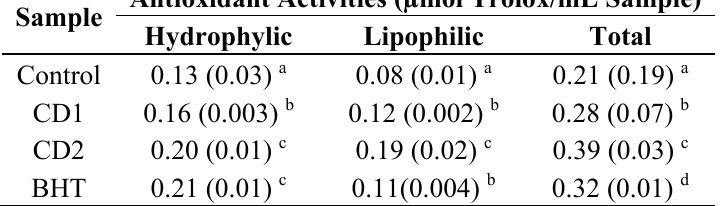
Figure 1. ( a ) AOC measured by FRAP water; ( b ) and FRAP lipid; assay for each treatment: Control (C), CD1 (0.1%), CD2 (0.5%) and BHT after 11 days of storage. The values represent mean ± standard error; Treatment means that do not share a common letter are different ( p < 0.05). Table 1. The antioxidant activities of C. decapetala (0.1% and 0.5%) and BHT in beef patties after 11 days of